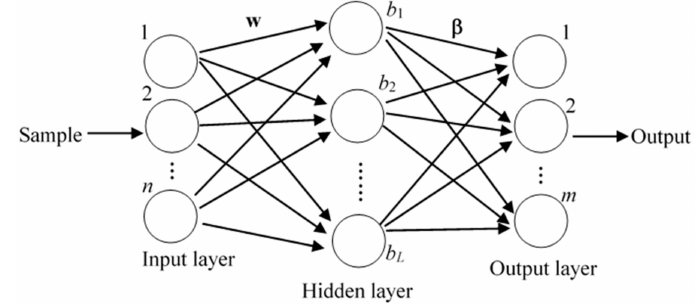
Figure 2. The basic structure of